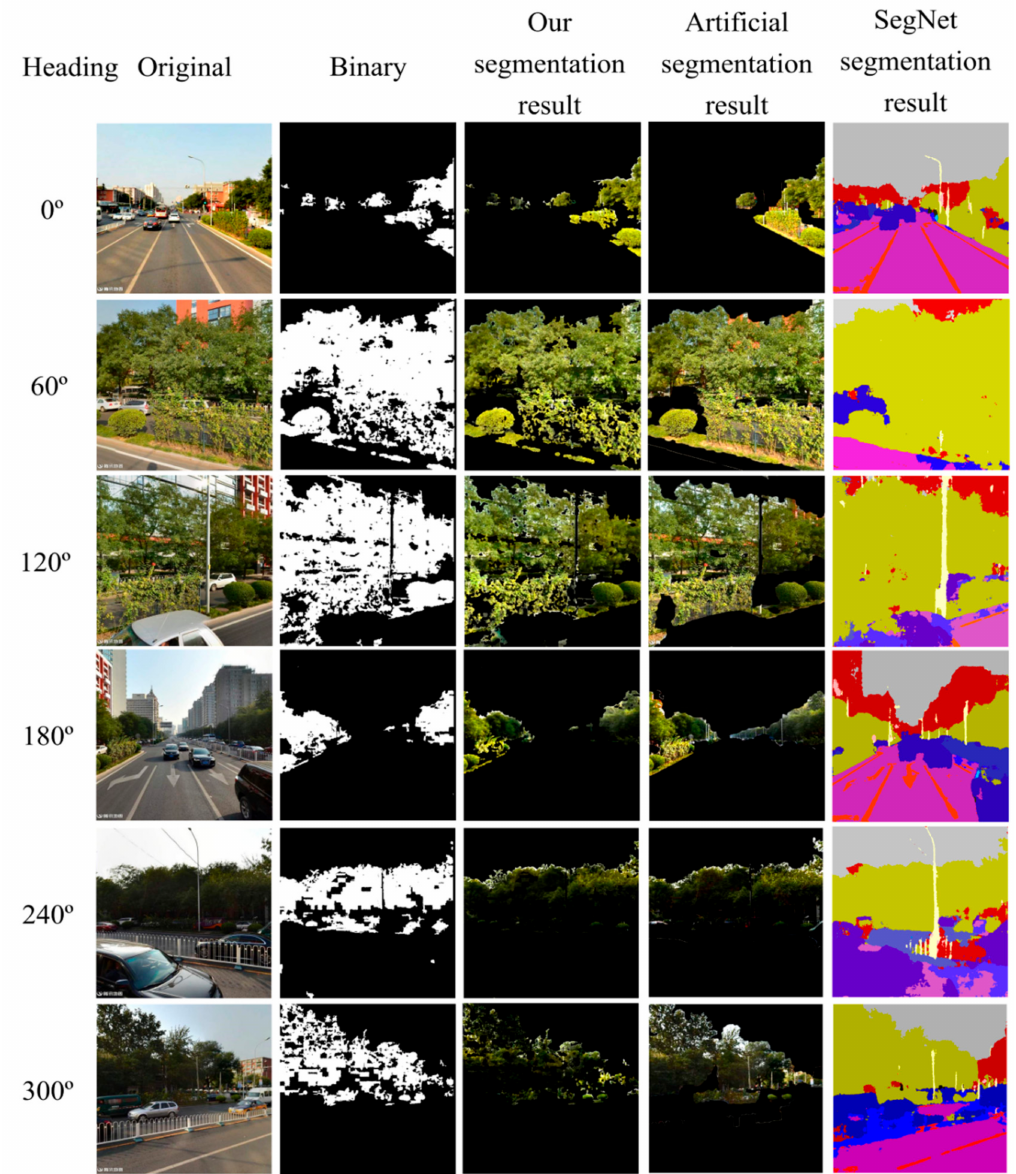
Figure 5. Comparison of segmentation results. Coordinates: 41.0574526 ◦ N, 116.635947 ◦